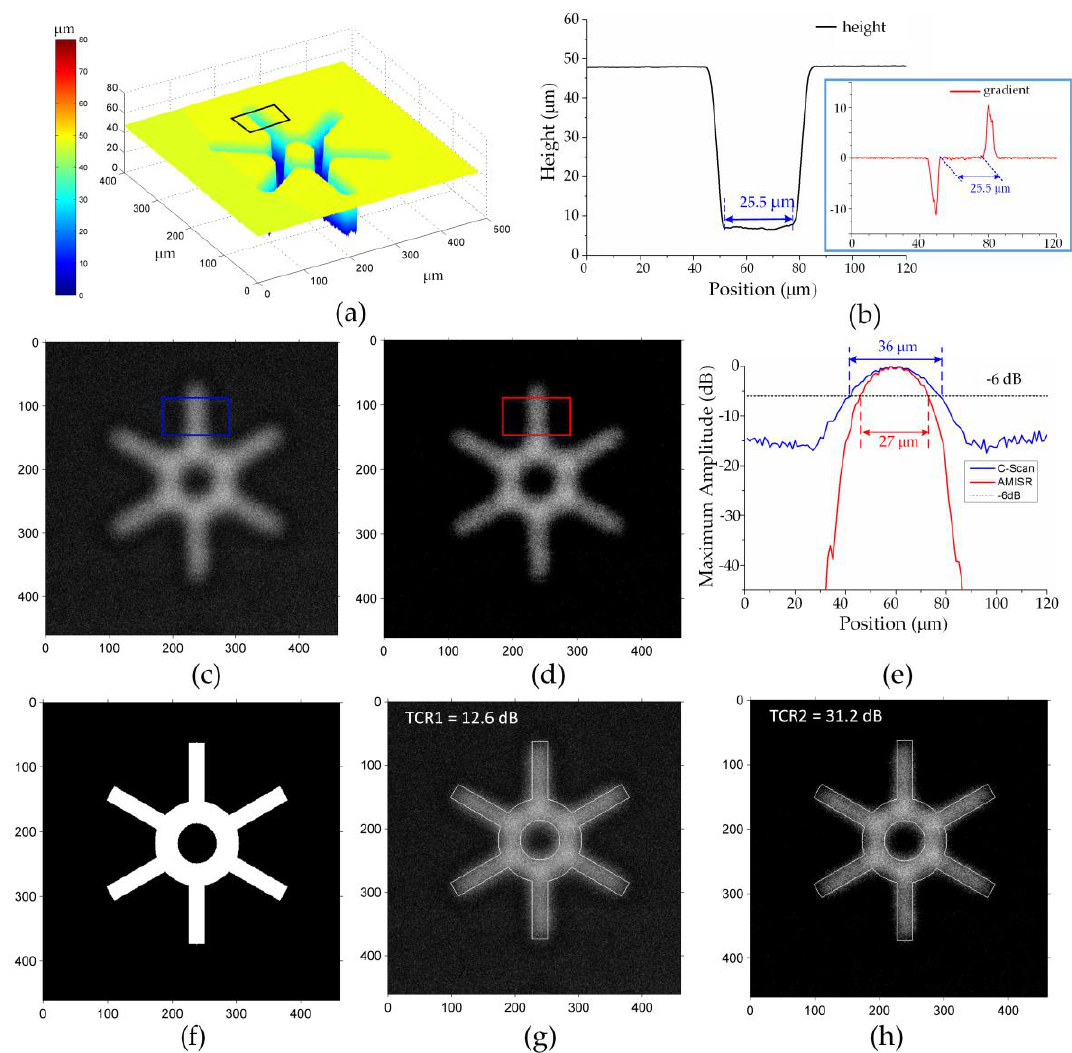
Figure 6. Results of complex defect (unit in µ m): ( a ) The topography of the defect; ( b ) Average profile of the branch; ( c ) Original C-scan image; ( d ) The reconstructed image formed by AMISR; ( e ) Average profile of the regions indicated in (c) and (d); ( f ) The cross section of the defect; ( g ) The original C-scan image superimposed with the mask; ( h ) The reconstructed image superimposed with the mask.